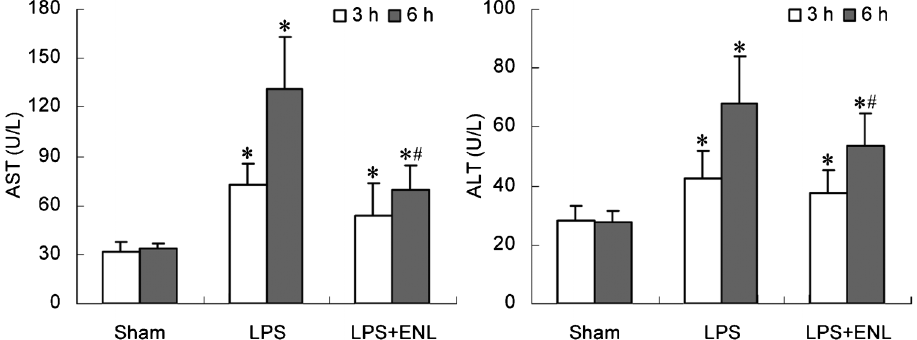
Figure 2. Effect of exogenous normal lymph (ENL) on indices of hepatocellular injury in rats. Data are reported as means±SD (n=10). *P , 0.05 vs the sham group; # P , 0.05 vs the lipopolysaccharide (LPS) group (one-way ANOVA). AST: aspartate aminotransferase; ALT: alanine aminotransferase.